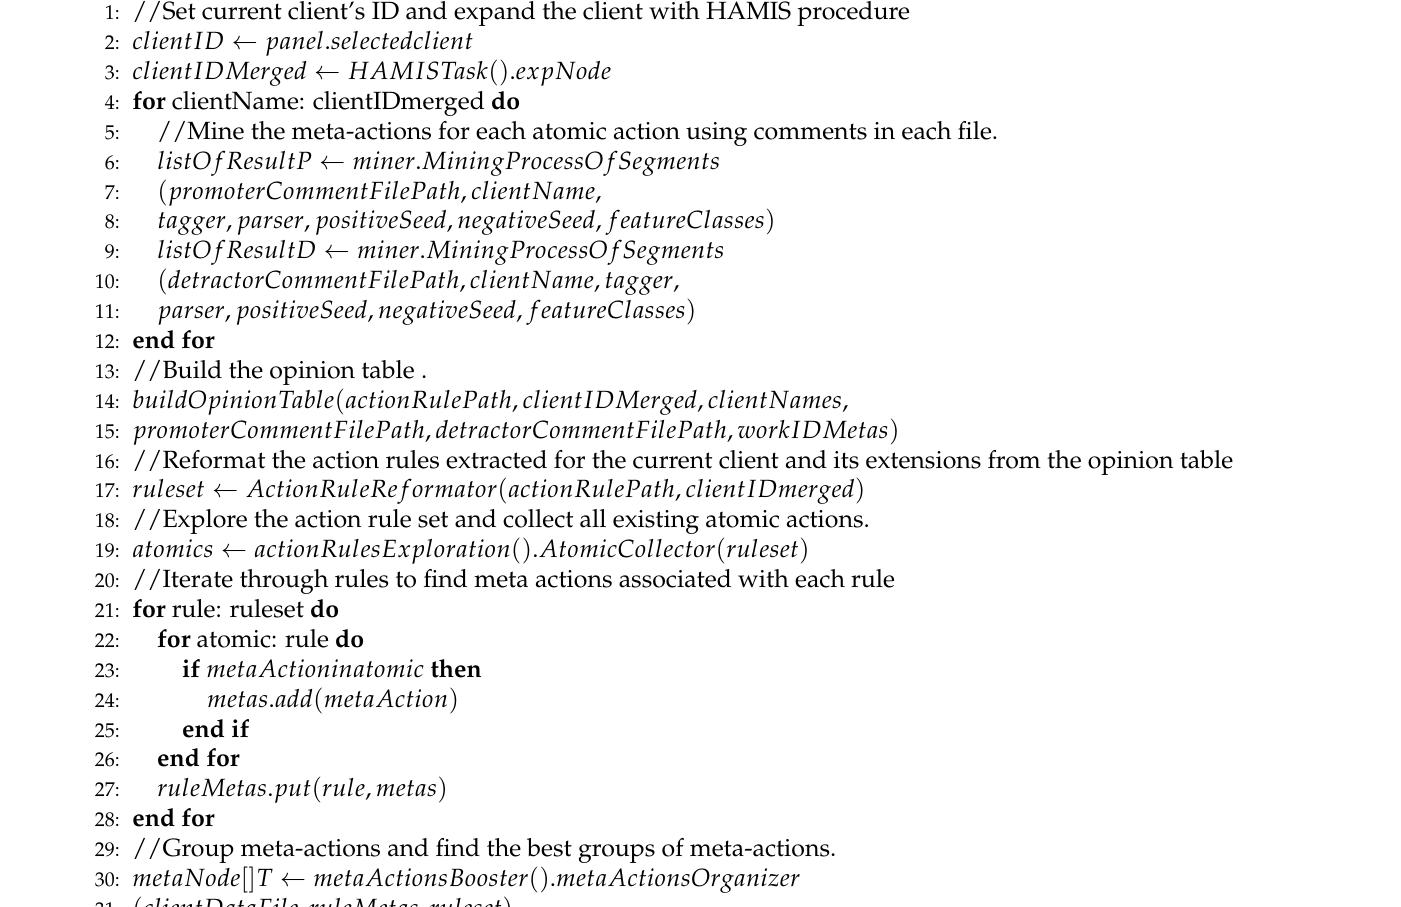
Algorithm 2 Modified algorithm of generating recommendations based on text feedback